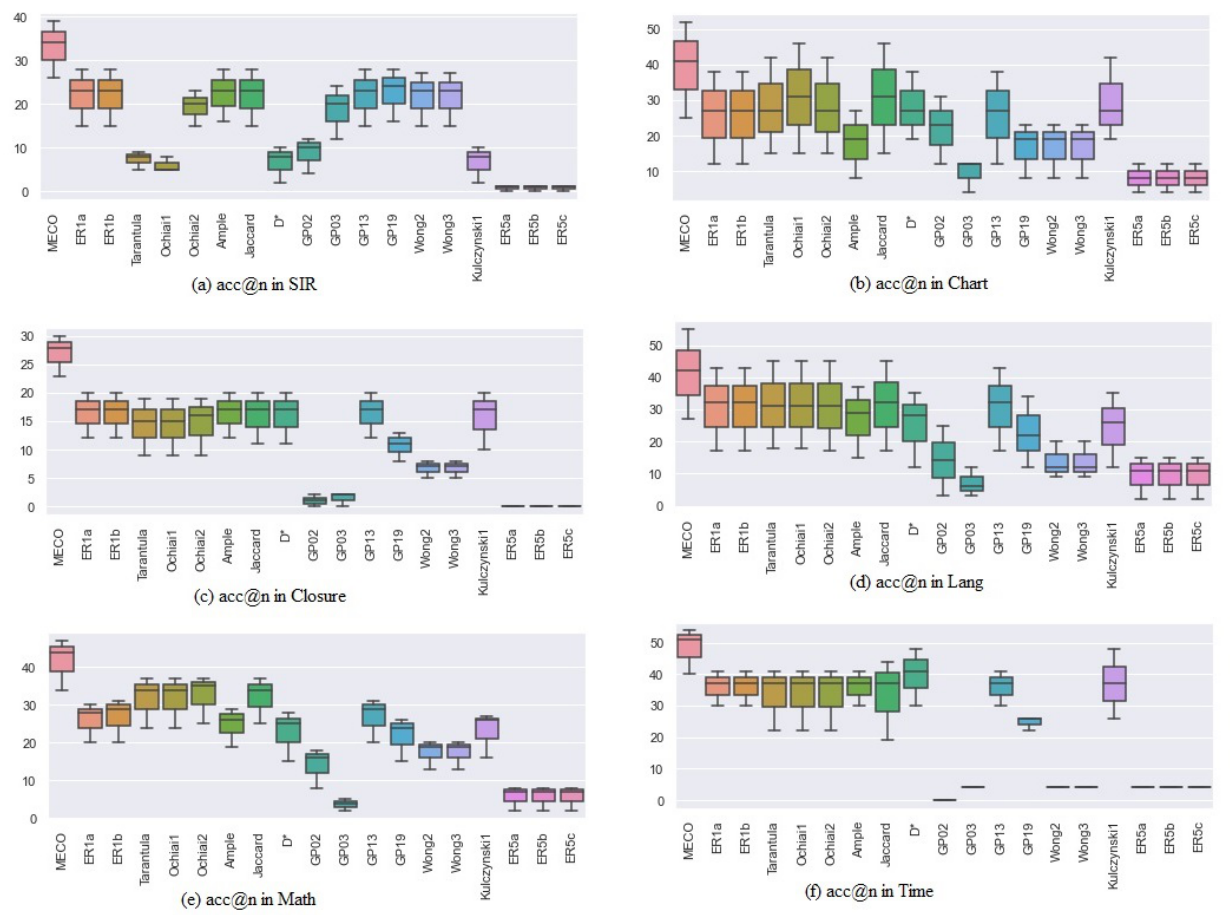
Figure 1. ( a ) shows the boxplot of MECO and the compared formulas in terms of acc@n in the SIR dataset. ( b ) shows the same comparison in the Chart. ( c ) shows Closure, ( d ) in Lang, ( e ) in Math and ( f ) in Time. Table 5. Performance comparison of the combined risk evaluation metrics with the standalone risk evaluation metrics in terms of Mean Average Precision and Wasted